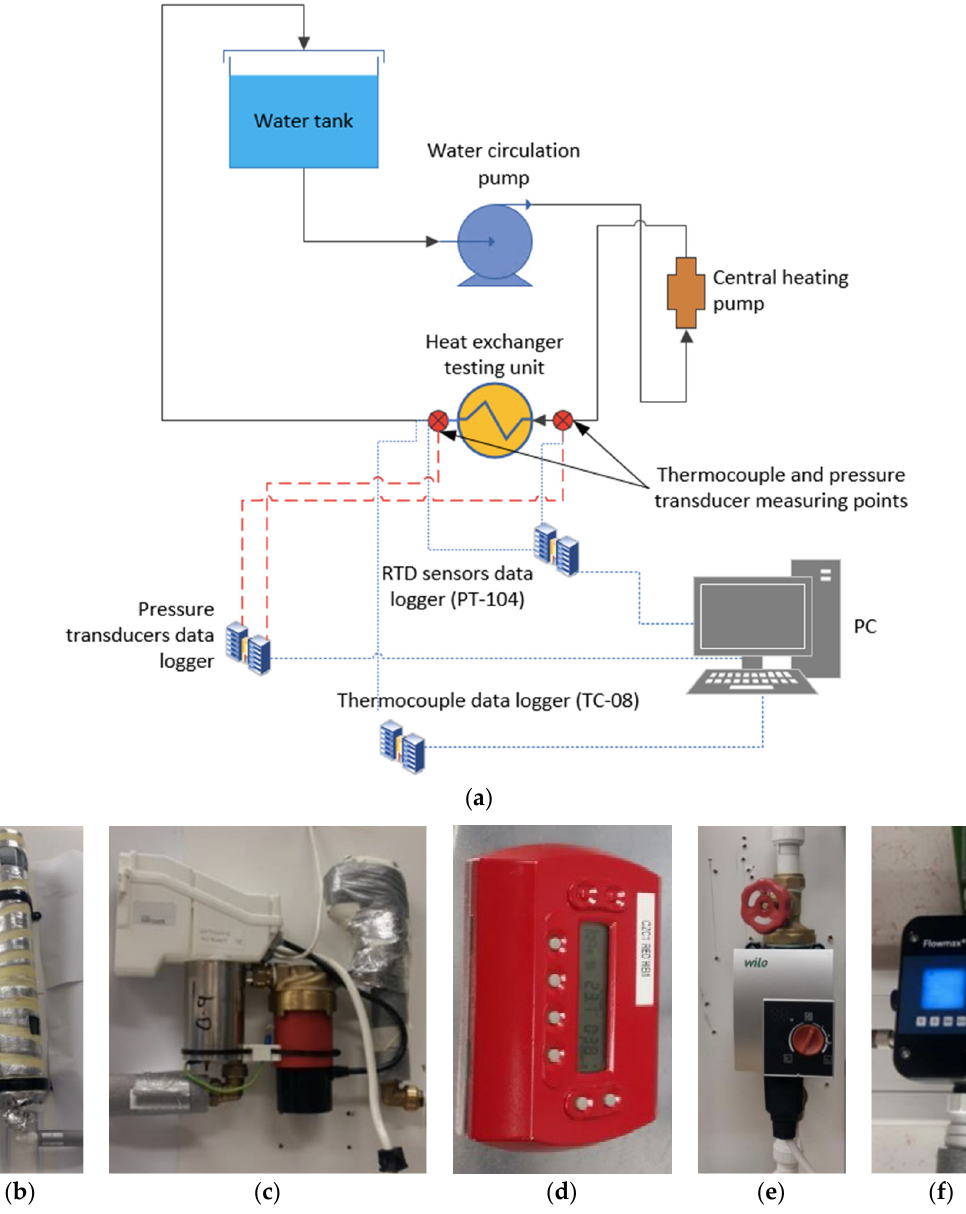
Figure 1. Schematic of the experimental setup: ( a ) overall schematic of a heater flow loop, ( b ) insu- lated 5 litre water tank, ( c ) water heater, ( d ) heater controller unit, ( e ) water pump, ( f ) water flow meter.